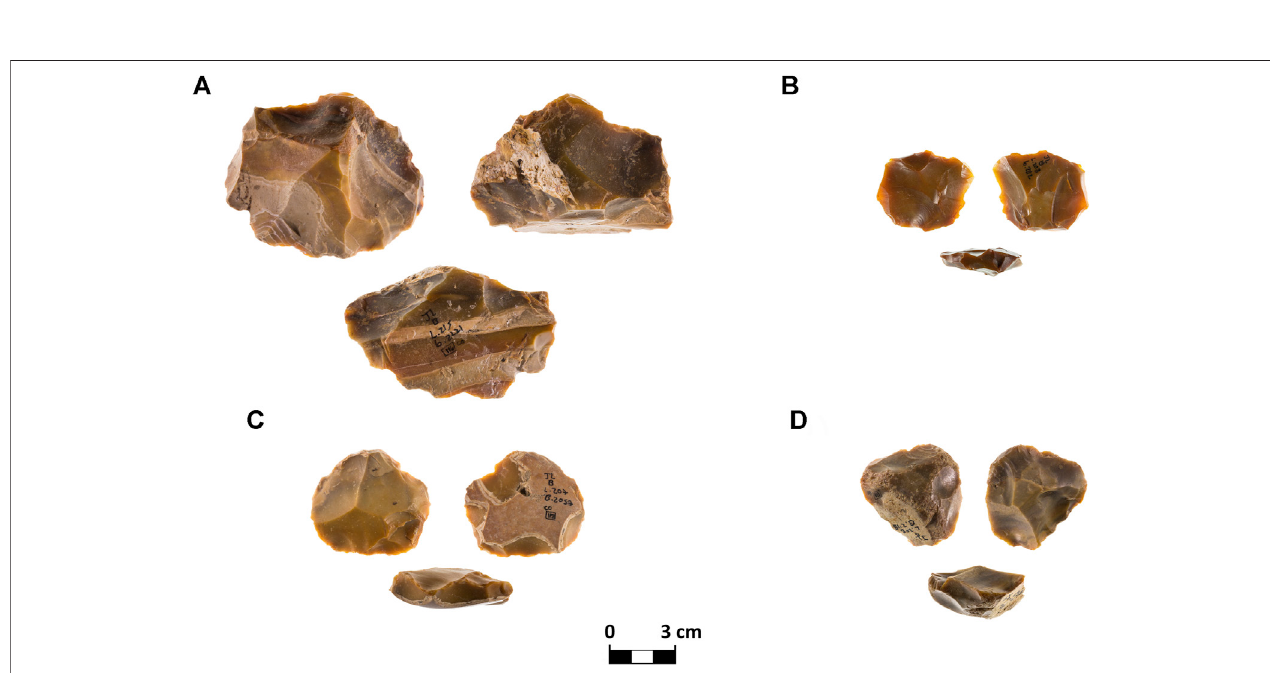
FIGURE 4 | Prepare Cores, made of fl int types of interest: (A) a discoid core made of brecciated heterogenous fl int type (Group 3); (B) a prepared core (general) made of brown homogenous, fi ne-textured fl int (Group 6); (C) a proto-Levallois core made of fi ne-textured, homogenous yellowish fl int (Group 1); (D) a proto-Levallois core made of brown, fi ne-textured homogenous fl int type (Group